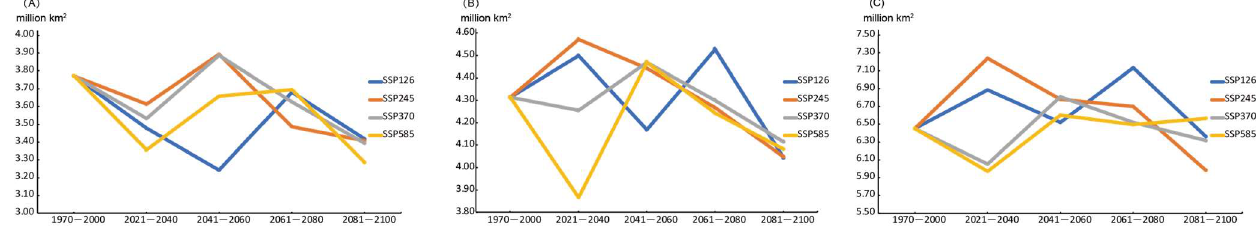
Figure 7. Variation trend of the amount of potentially suitable area under four scenarios. (( A ) highly suitable area; ( B ) moderately suitable area; ( C ) marginally suitable area).